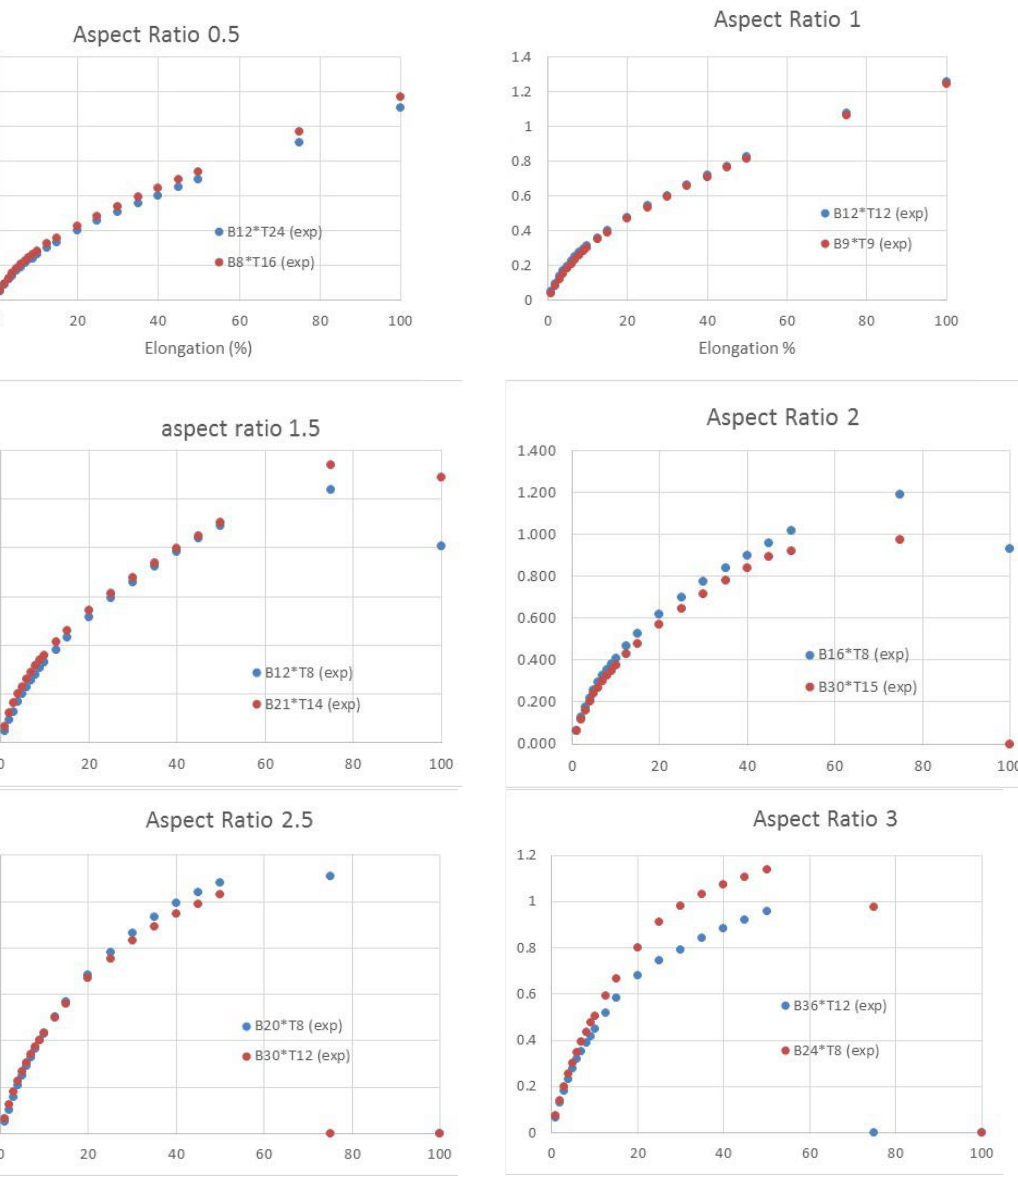
Fig. 1: Stress (MPa) versus strain (%) for the different aspect ratios and H-piece dimensions We observe a good correspondence between the behaviors of 2 samples with the same aspect ratio. As the aspect ratio increases, we observe a gradual increase of stress for a same strain (at 20%, the stress increases from 0.4MPa for AR=0.5 to 0.7MPa for AR=3). The stress at rupture is almost constant around 1-1.2MPa independent of the